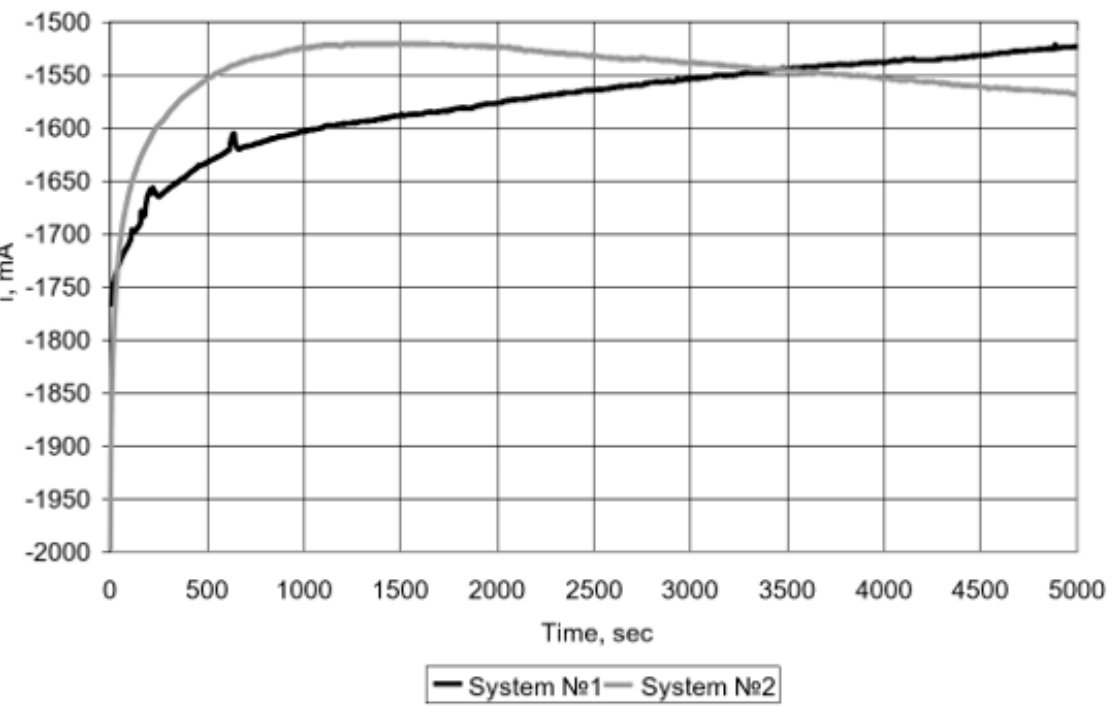
Figure 4. Dependence of current on time (potentiostatic mode, E = 500 mV) when supplied to the fuel cell: (1) H 2 –98% + CH 4 –2% (vol.); (2) H 2 (99.999% v/v ).